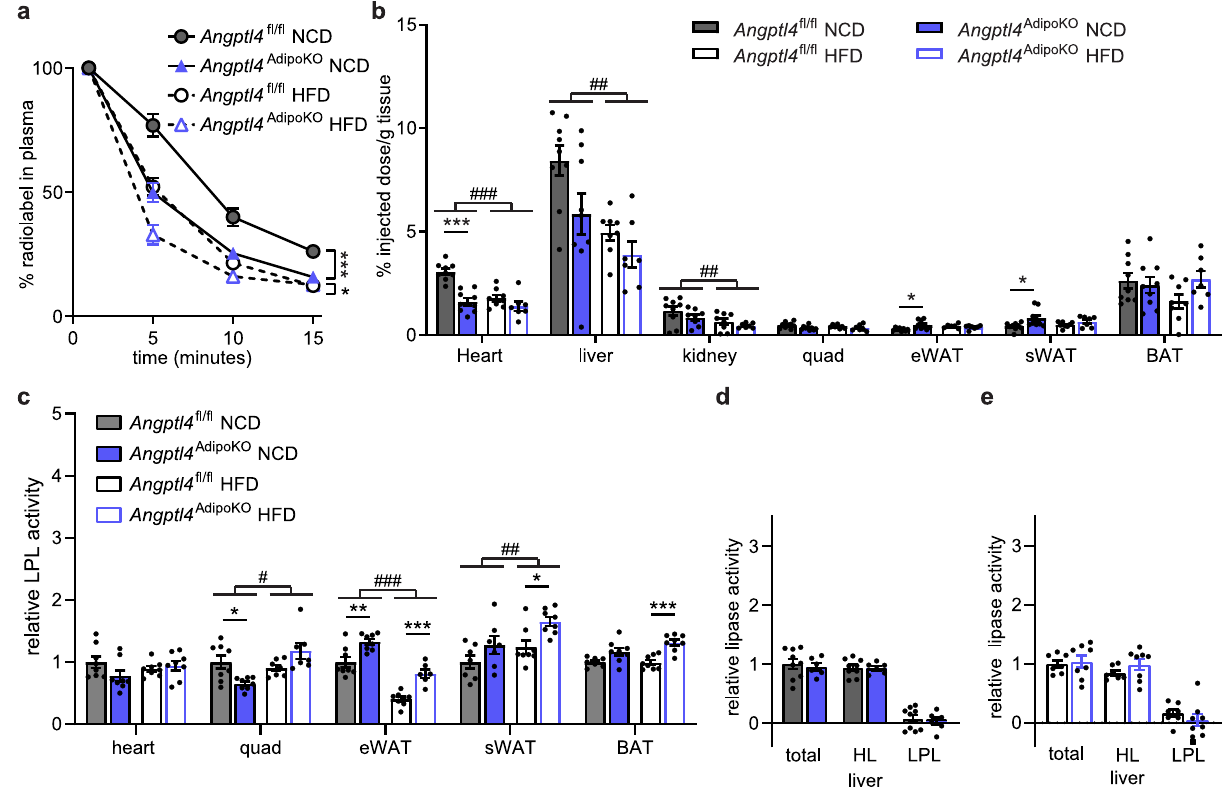
Figure 6. Chylomicron clearance and uptake and lipase activity in Angptl4 AdipoKO mice after chronic high-fat feeding. At the conclusion of 6 months of either normal chow diet (NCD) or high fat diet (HFD) Angptl4 fl/fl and Angptl4 AdipoKO male mice (n = 7–9/group) were fasted (6 h) and injected intravenously with 3 H-triglyceride containing chylomicrons. ( a ) Clearance of radiolabel from the plasma 1, 5, 10, and 15 min after injection. Points represent percentage of radiolabel remaining in the plasma at the indicated time points compared to the 1-min time point (mean ± SEM). ***p < 0.001 by repeated measures ANOVA. ( b ) Uptake of radiolabel (% injected dose/g tissue) into the indicated tissues after 15 min (mean ± SEM). #p < 0.05, ##p < 0.01, ###p < 0.001 for dietary differences by two-way ANOVA. *p < 0.05, ***p < 0.001 for individual genotype-specific differences by multiple comparison after two-way ANOVA. ( c ) Heart, quadricep muscle (quad), epididymal adipose tissue (eWAT), subcutaneous adipose tissue (sWAT), and brown adipose (BAT) tissue from fasted (6 h) male Angptl4 fl/fl and Angptl4 AdipoKO mice were harvested and lipase activity was measured (n = 6–8/group). ( d , e ) Liver was harvested from fasted (6 h) male Angptl4 fl/fl and Angptl4 AdipoKO mice (d, NCD groups and e, HFD groups)(n = 6–9/ group). Lipase activity was measured in the presence or absence of 1 M NaCl to distinguish between hepatic and lipoprotein lipase. Bars show relative lipase activity in each tissue normalized to Angptl4 fl/fl (mean ± SEM). #p < 0.05, ##p < 0.01, ###p < 0.001 for dietary differences by two-way ANOVA. *p < 0.05, **p < 0.01 ***p < 0.001 for individual genotype-specific differences by multiple comparison after two-way